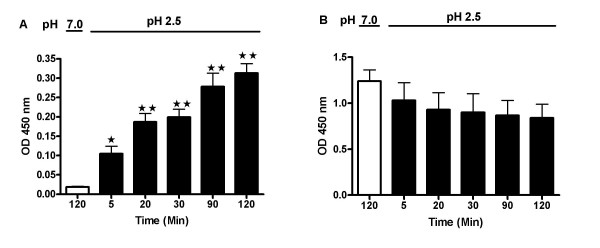
Duration of pH 2.5 exposure differentially affects ELISA signals in sera from unvaccinated nonTg mice compared to vaccinated nonTg mice. Sera were collected from unvaccinated mice (3A) and mice vaccinated with human Aβ1–42 peptide (3B), diluted 1:400. Aliquots were incubated with dissociation buffer at pH 7 (open bar, 120 min) or pH 2.5 (solid bars) for 5, 20, 30, 90 and 120 minutes. The ELISA assays were completed as described in methods and the optical density at 450 nm used to estimate the amount of antibody binding to the ELISA plate. Results are presented as mean ± SEM. * P < 0.05; ** P < 0.001 compared to pH 7.0.